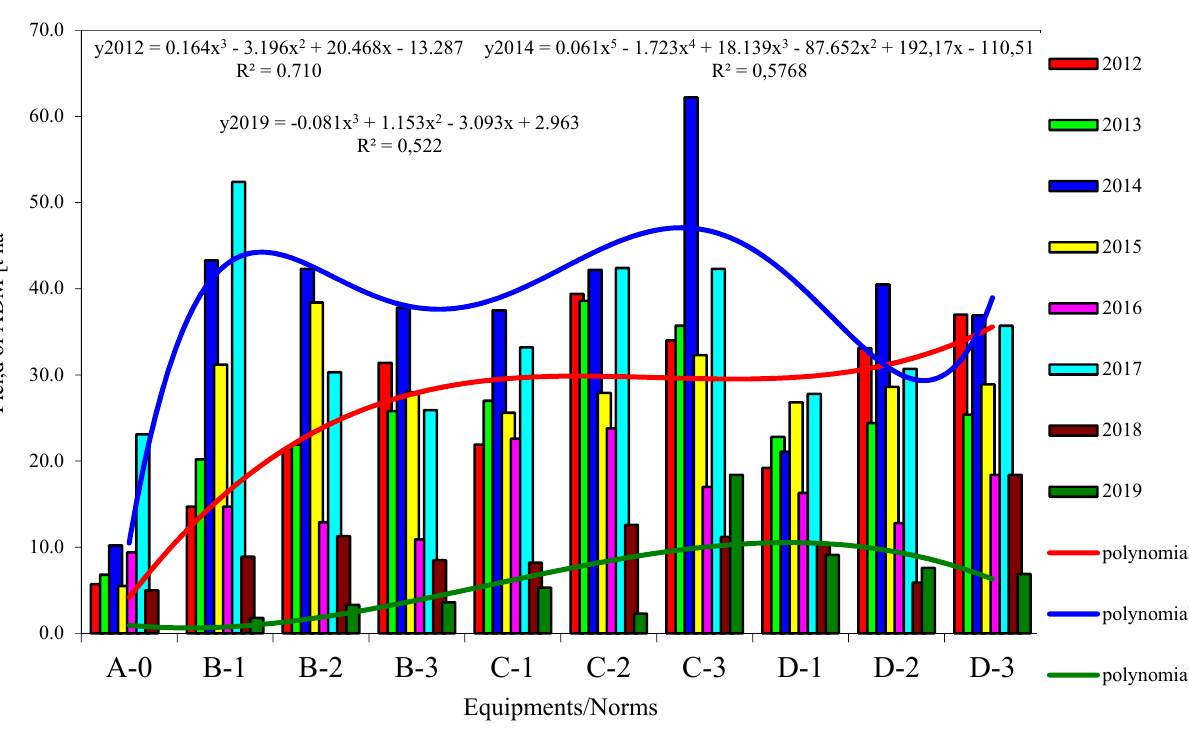
Figure 8. The share of T. repens in ADM of 4th pasture rotation (2012–2019). Tillage treatments: A—control object (without overseeding), B—underseeding after heavy tine harrow, C—underseeding after disc harrow, D—underseeding after the rotary tiller.